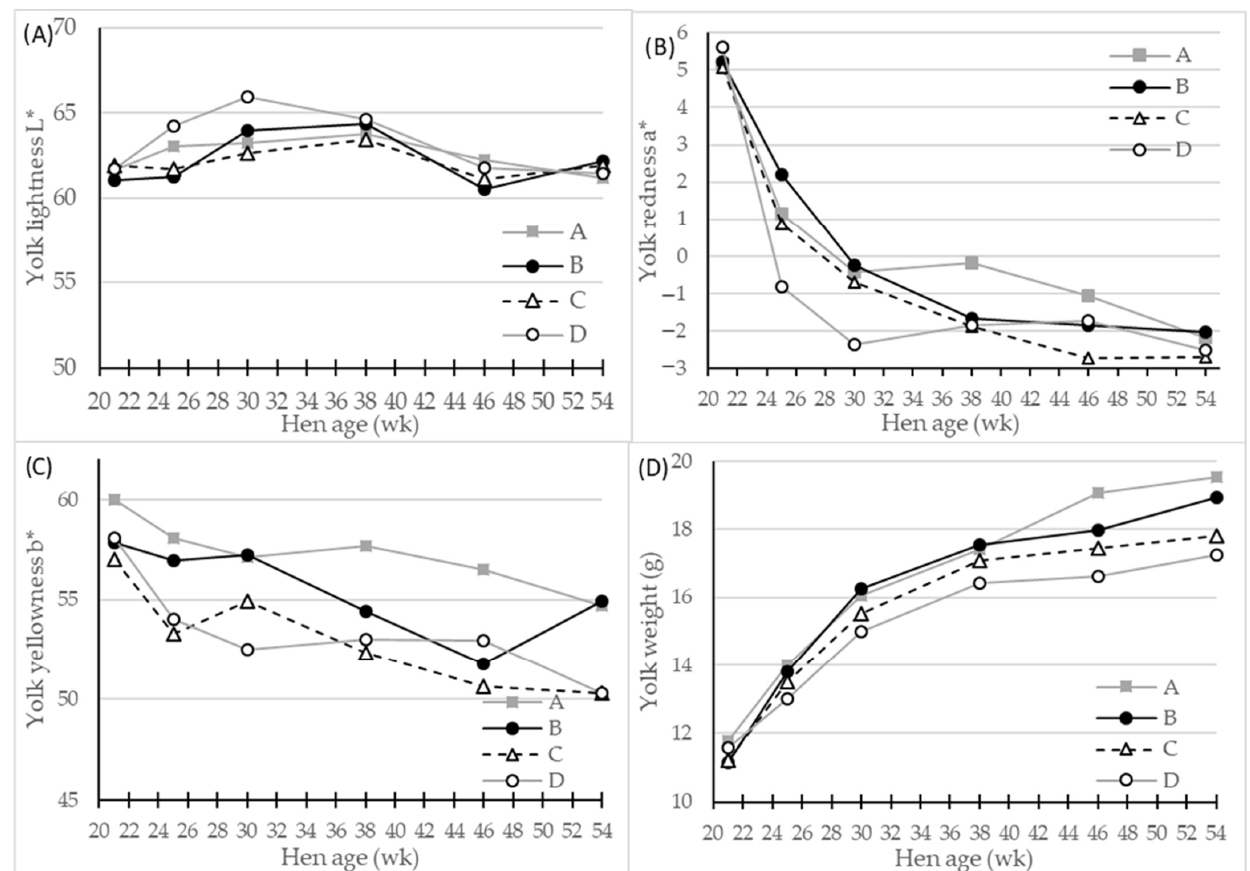
Figure 3. LS-means of egg yolk color parameters and egg mass of four different hen genotypes ( A – D ) as differentiated by hen age (week). Panels showing ( A ) L* (lightness), 0 = black, 100 = white, ( B ) a* (redness), −100 = green, 100 = red, ( C ) b* (yellowness), −100 = blue, 100 = yellow, and ( D ) egg yolk weight, n = 30 for genotype A and 45 for genotypes A, B and C, significant interactions of hen age * genotype ( p < 0.01) for all parameters.